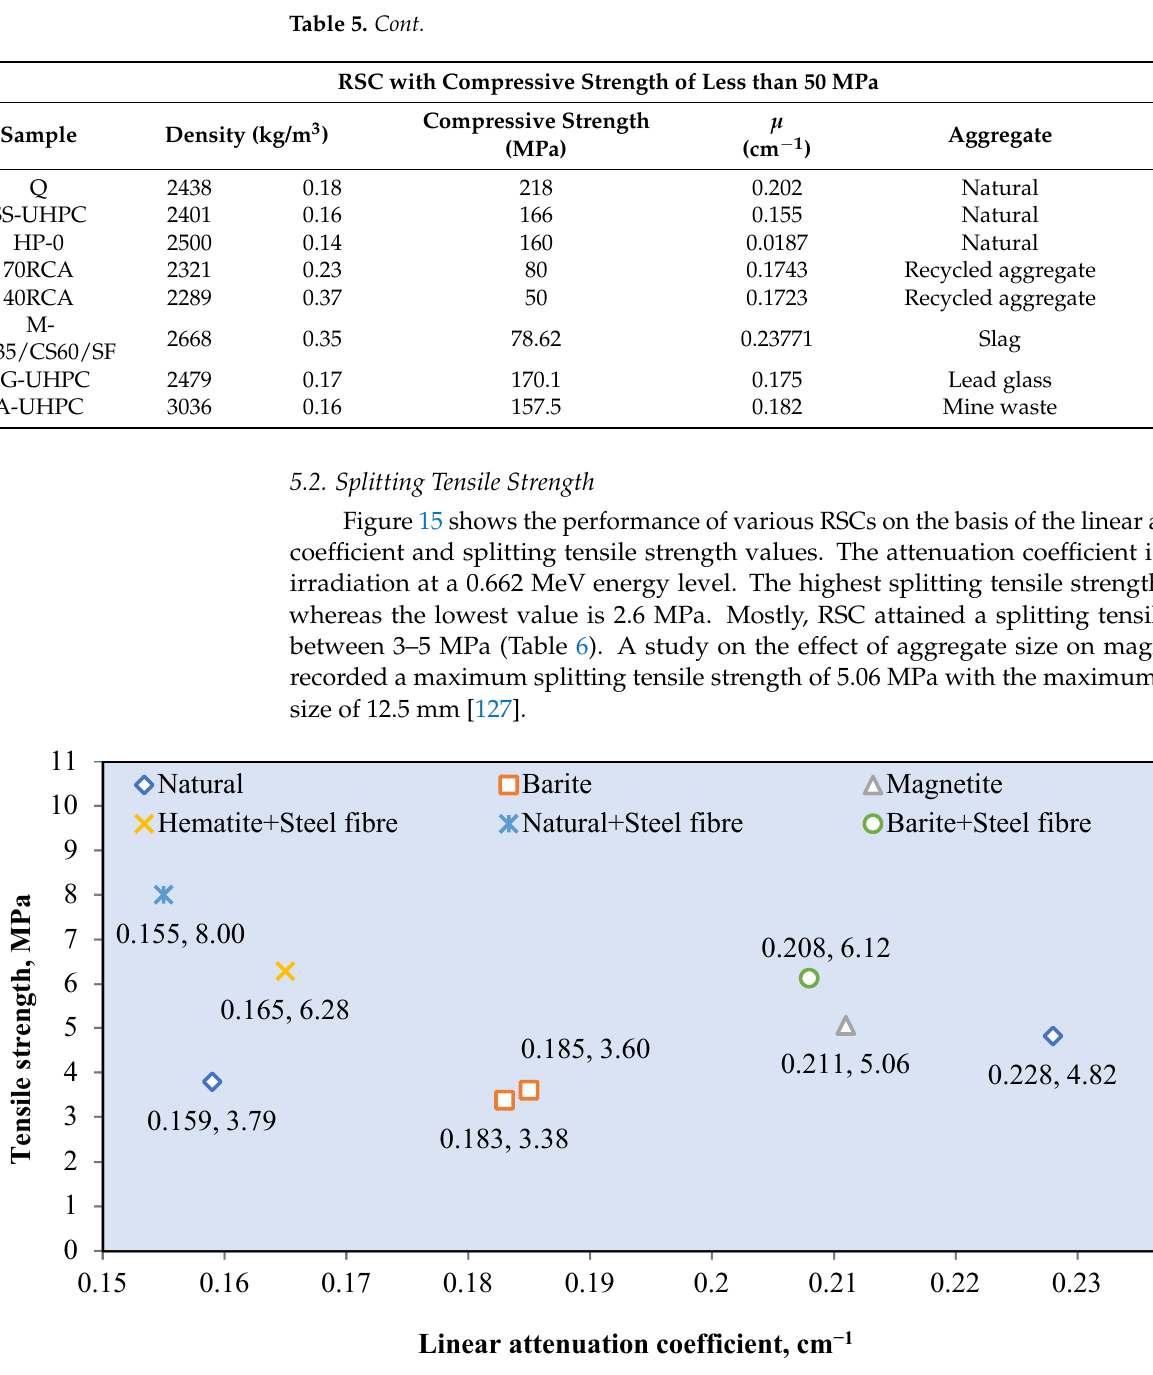
Table 6. List of RSC with tensile strength value.